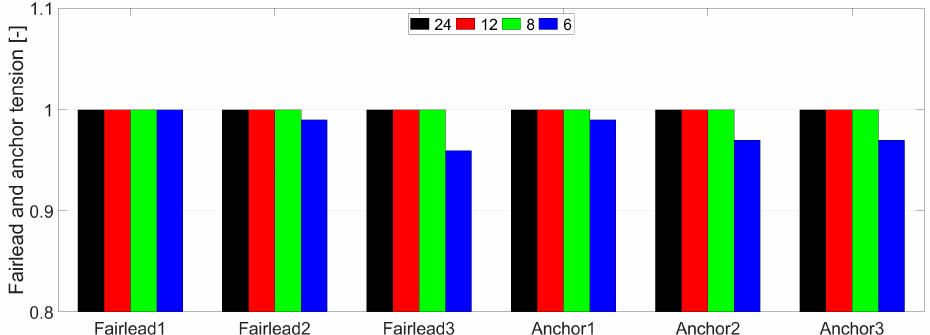
Figure 18. Normalized values for maximum blade and tower’s moments according to the interval angles.